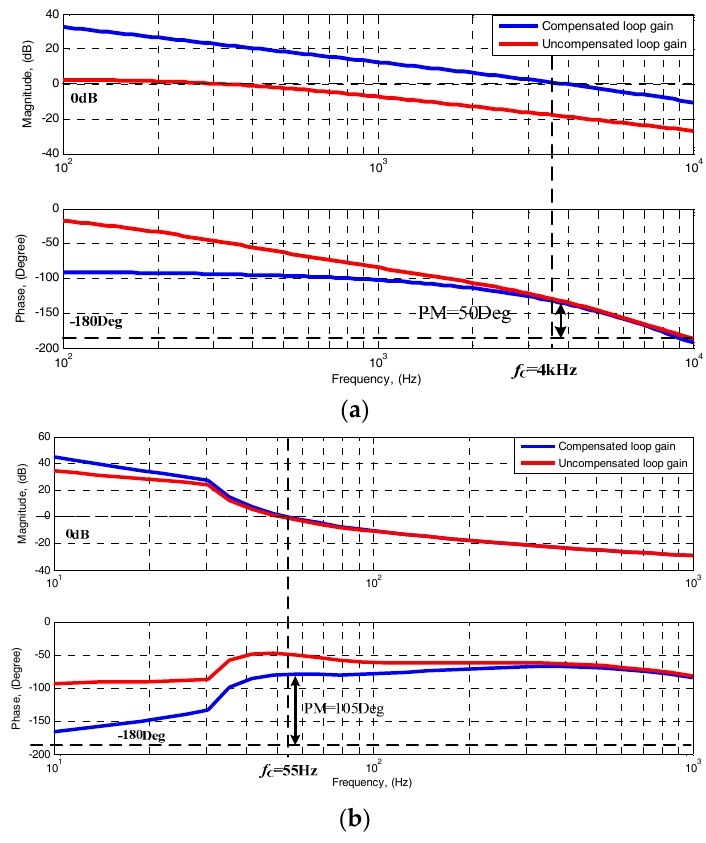
Figure 5. Frequency responses of the loop gain: ( a ) compensated current loop and ( b ) compensated voltage loop.